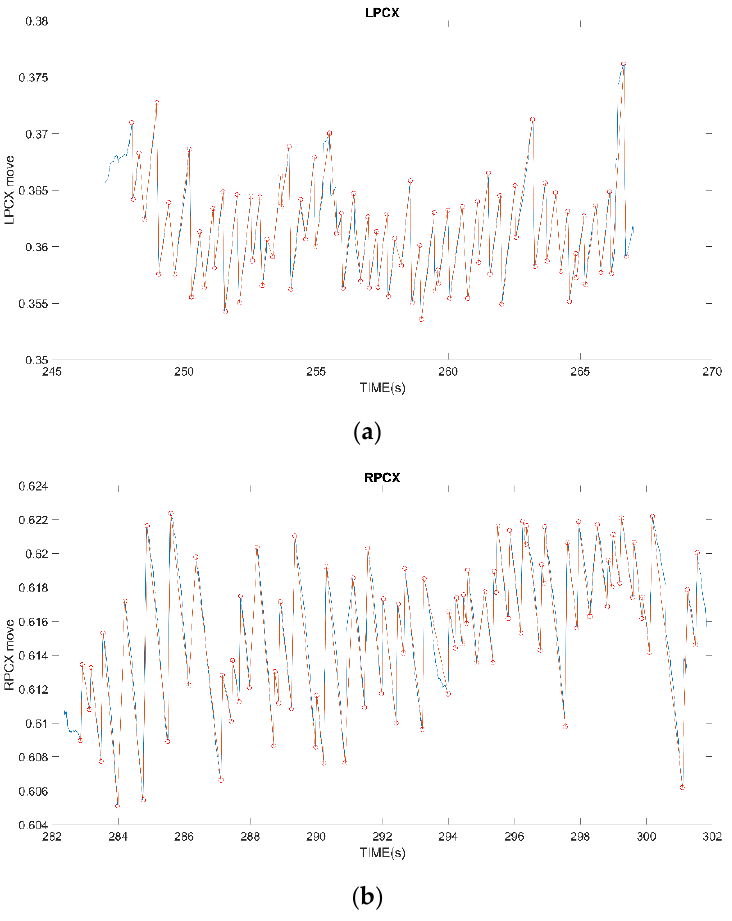
Figure 6. ( a ) Left-shifted striped OKN test; ( b ) Right-shifted striped OKN test.